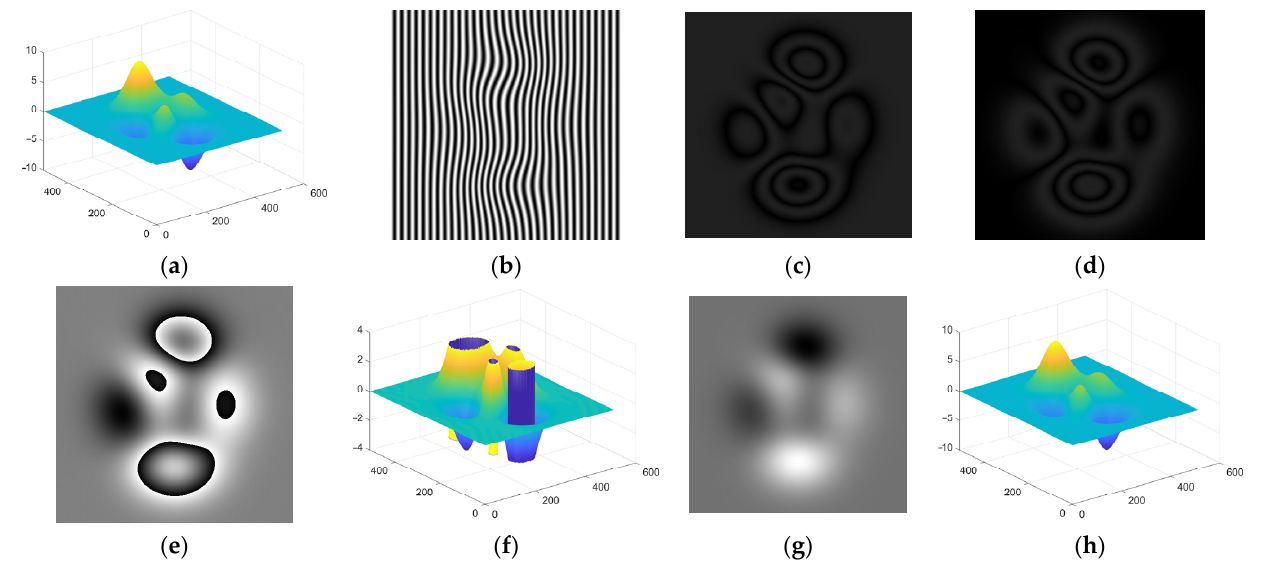
Figure 3. Simulation experiment results of peaks. ( a ) object; ( b ) deformed fringe pattern; ( c ) moire fringe pattern 1; ( d ) moire fringe pattern 2; ( e ) wrapped phase; ( f ) wrapped phase reconstruction result; ( g ) unwrapped phase; ( h ) unwrapped phase reconstruction result.